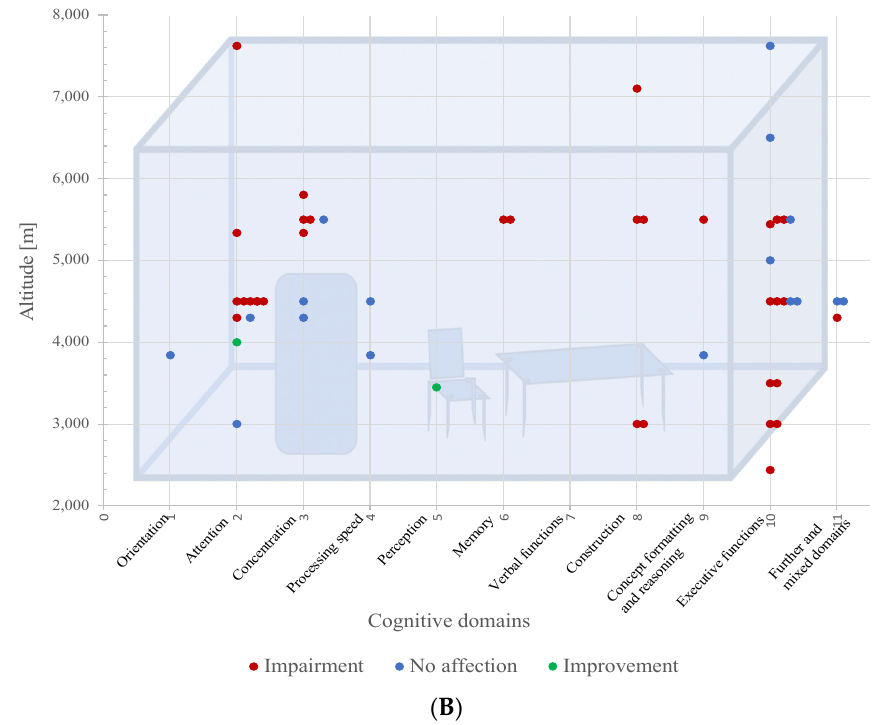
Figure 2. ( A ) Test results in the field studies . ( B ) Test results in the laboratory studies.